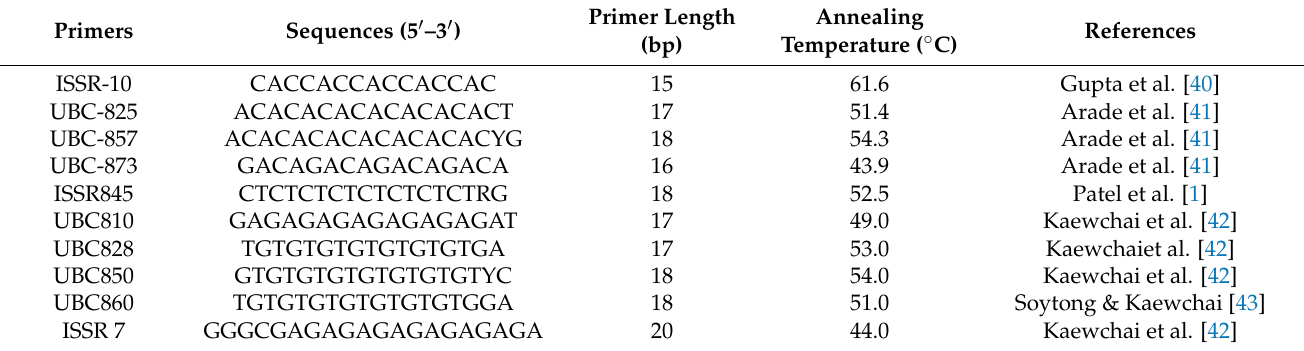
Table 2. Details of ISSR primers used in this study to differentiate C. falcatum